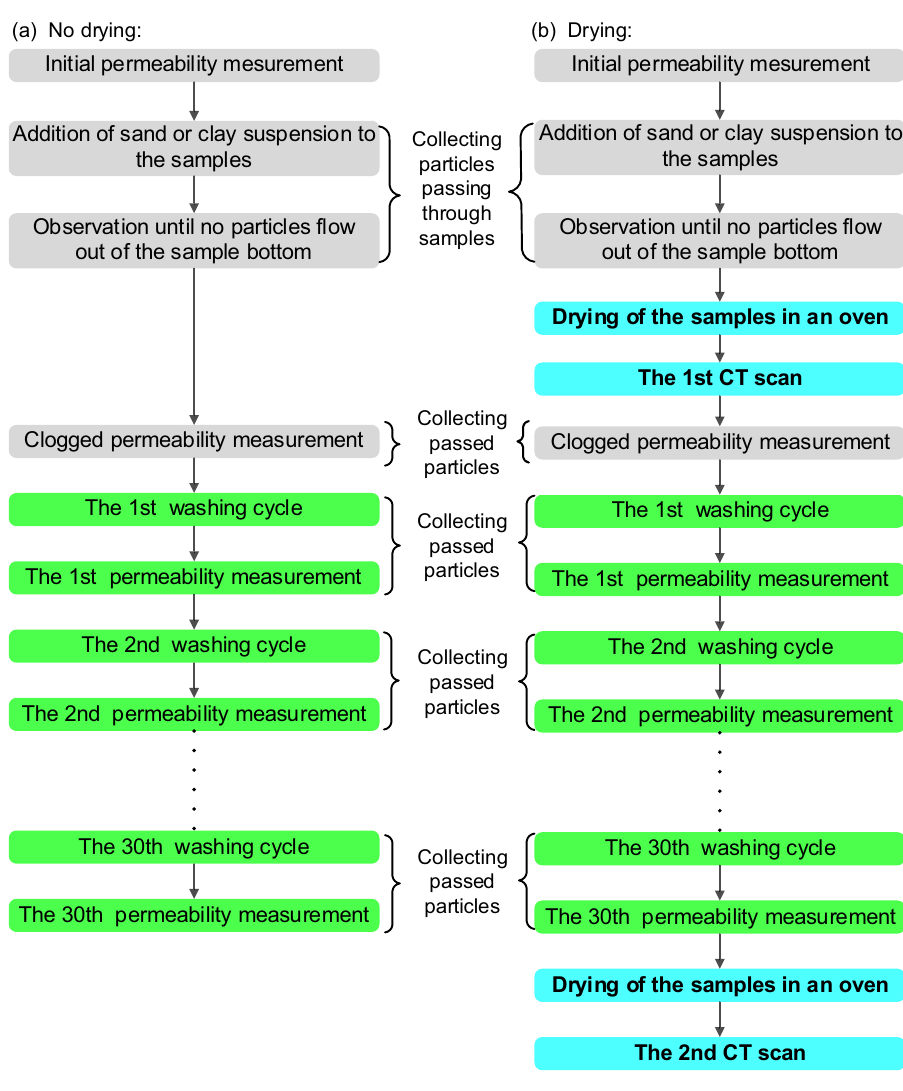
Figure 5. Flow diagrams of the experiments: ( a ) no drying and ( b )